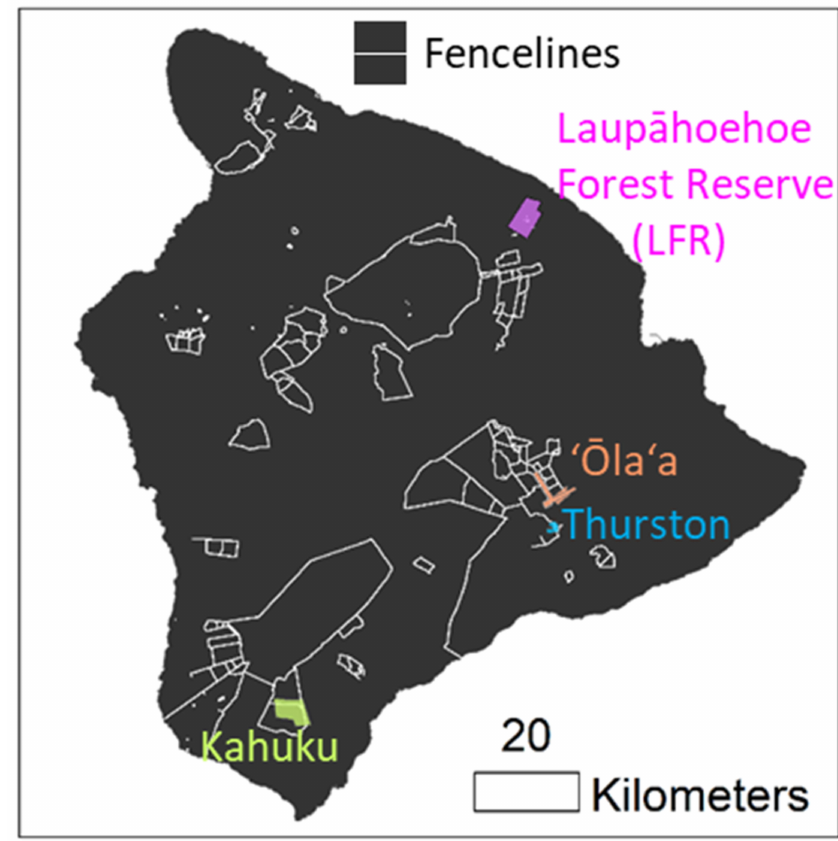
Figure 1. Study site locations on Hawai‘i island and fence